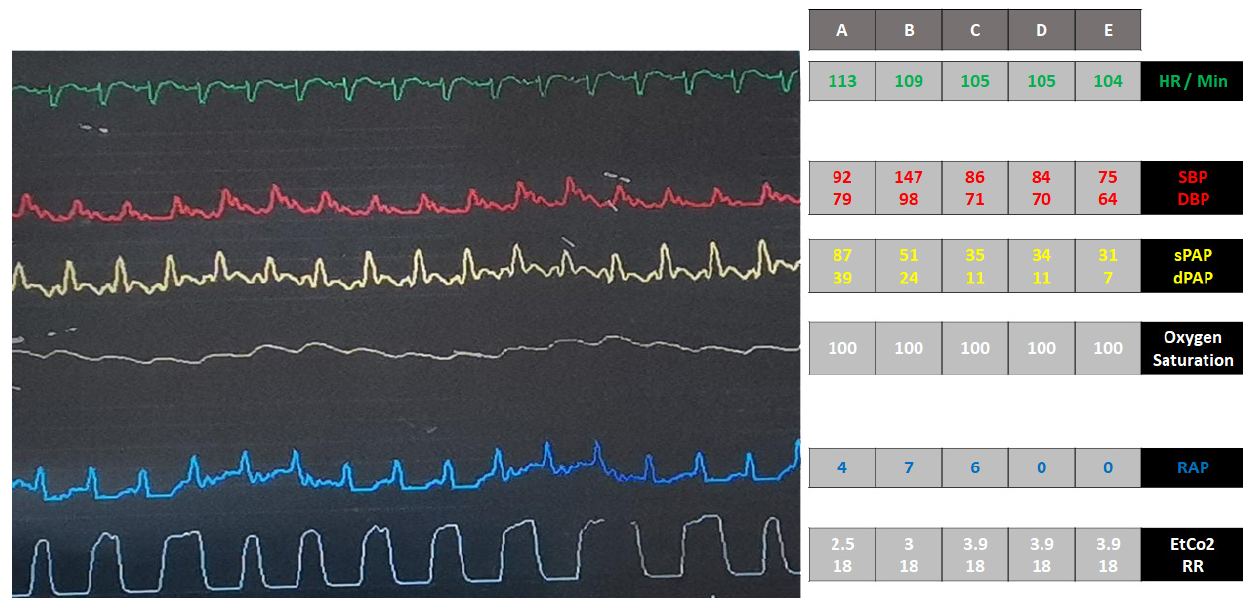
Figure 1. Hemodynamic profiles after Impella placement. Hemodynamics deterioration (panel A ); normalization of pulmonary pressures and hemodynamics stabilization after the patient started mechanical ventilation with inhalation of 20 parts per million of nitric oxide (panel B and C ); clinical picture deterioration (panel D and E ) being refractory to further increase of inotropes. HR = heart rate; SBP = systolic blood pressure; DBP = diastolic blood pressure; sPAP = systolic pulmonary artery pressure; dPAP = diastolic pulmonary artery pressure; RAP = right atrial pressure; EtCO2 = end-tidal CO2; RR = respiratory rate Sodium nitroprusside was discontinued due to hypotension. Intravenous fluids and red blood cell transfusions were delivered, and epinephrine was started at 0.12